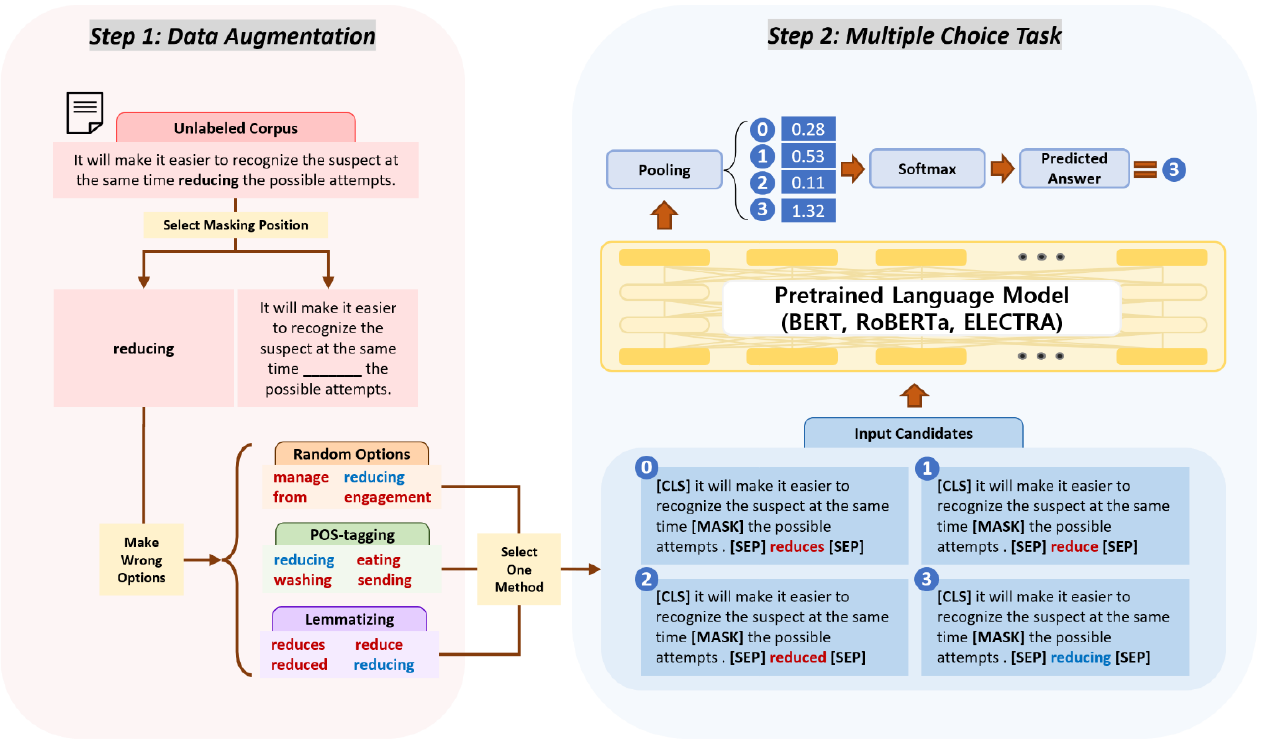
Figure 2. Overall process. The figure on the left corresponds to “Step 1: Data Augmentation” and the figure on the right corresponds to “Step 2: Multiple Choice Task”.